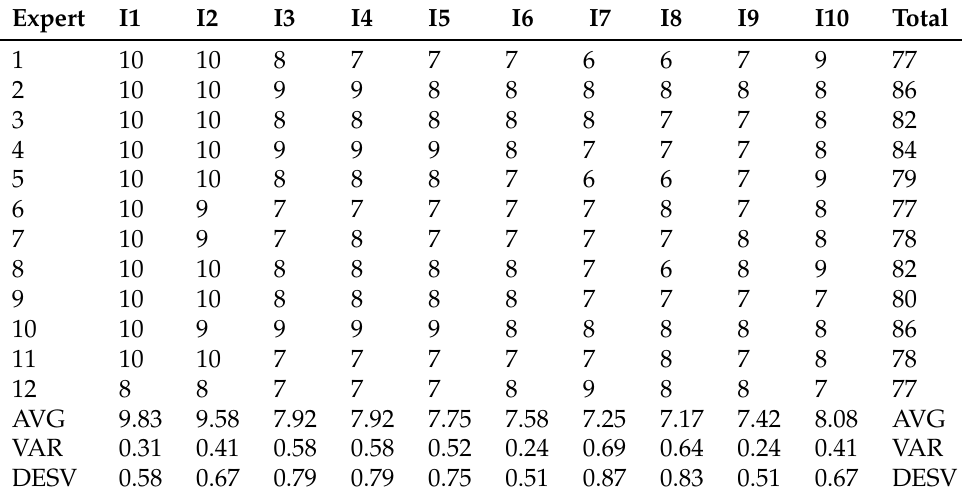
Table 5. Evaluation of incentives for carpooling from